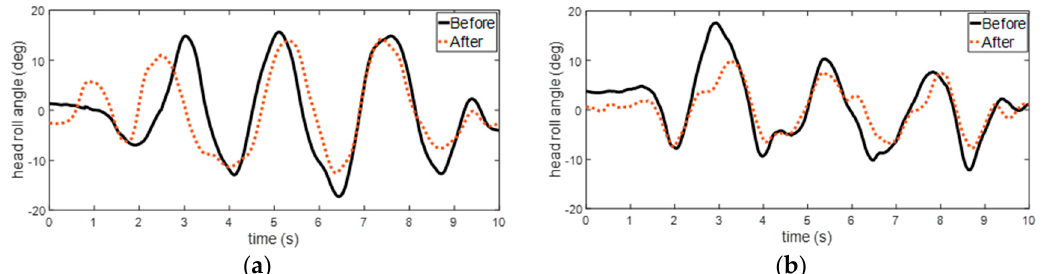
Figure 11. Head roll responses: ( a ) participant 1 and ( b ) participant 2.